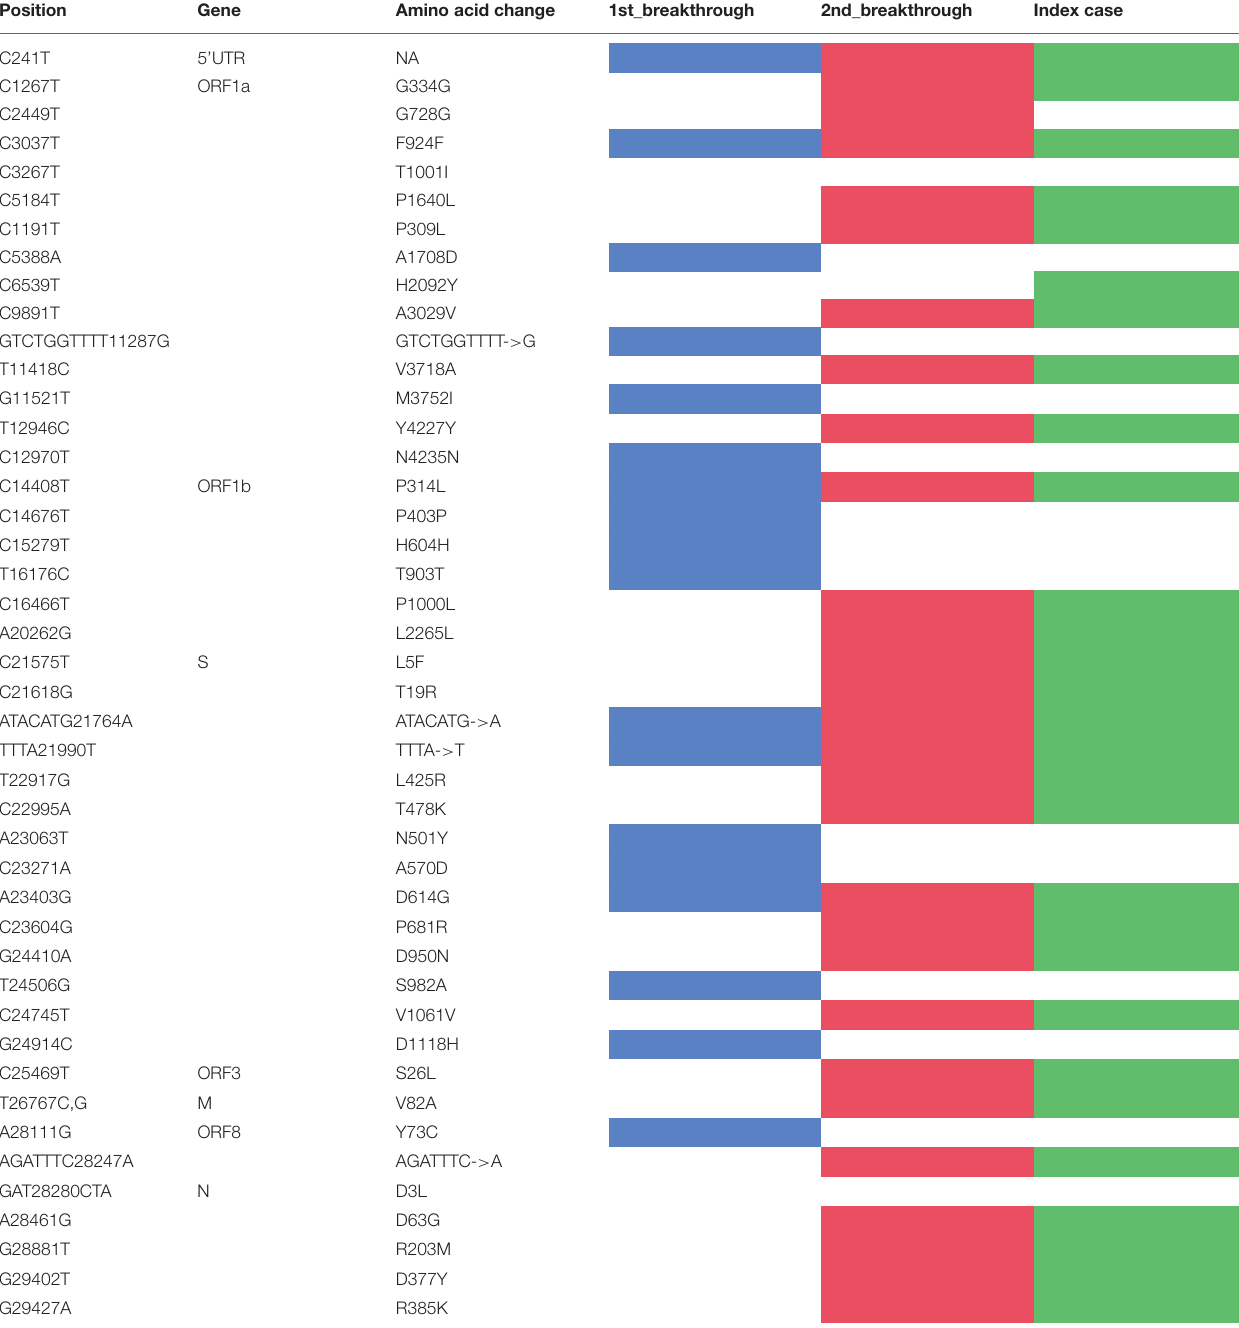
TABLE 3 | List of mutations seen in the three samples. Position Gene Amino acid